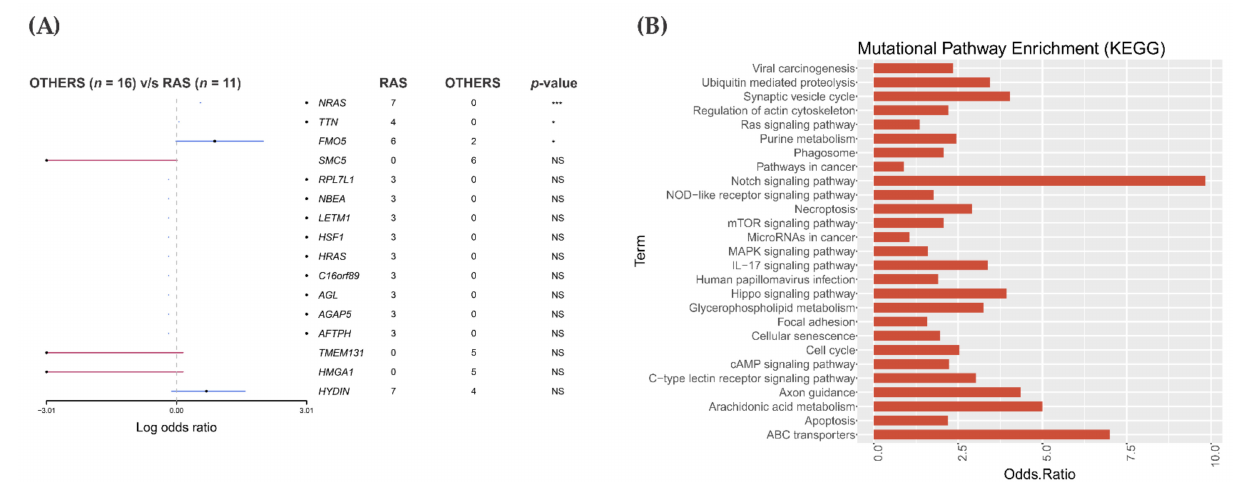
Figure 2. Mutational analysis and pathway enrichment in the RAS -positive cohort. ( A ) Forest plot shows representative genes that were recurrently mutated in the 11 RAS -positive groups or in the “others” group (samples negative for the driver mutation). The black points indicate genes exclusively mutated in the RAS cohort. The blue line shows genes mutated in both groups and the red line the ones mutated exclusively in the “others” group. Recurrent mutations were considered those mutations that occurred in at least two samples. *** p -value = 0.001, * p -value ≤ 0.05, NS = non-significant p -value ( B ) A KEGG pathway enrichment of the 126 exclusively mutated in the RAS